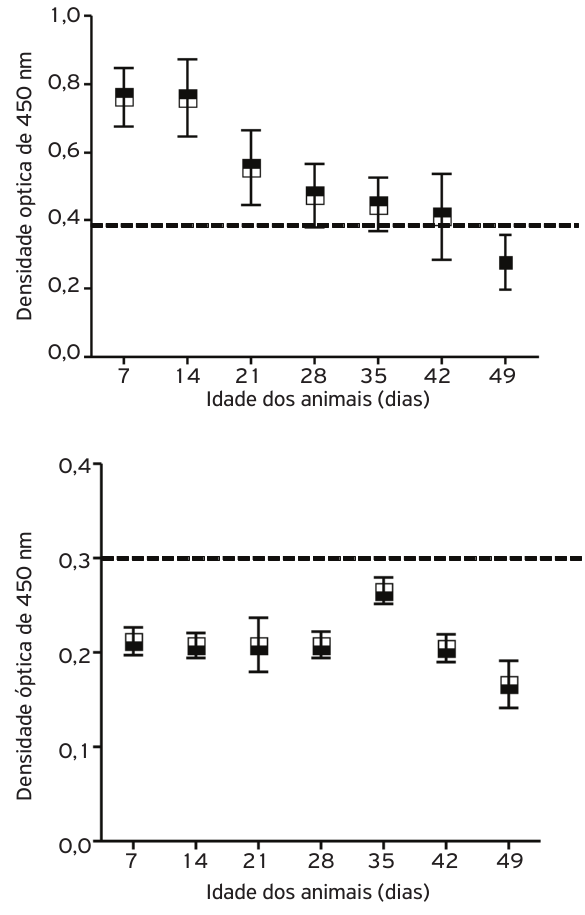
Idade dos animais Figura 2. Dados referentes ao status imunológico dos 16 leitões dos 7 aos 49 dias de idade baseados na leitura do índice ELISA (INGEZIM Circovirus IgG/IgM, Ingenasa, Espanha). (A) Valores (médio ± desvio padrão) da densidade óptica (DO) (450 nm) para IgG anti-PCV2, (B) Valores (médio ± desvio padrão) da DO (450 nm) para IgM anti-PCV2. A linha tracejada corresponde ao valor médio da DO (450 nm) de corte obtida nas leituras realizadas no período.